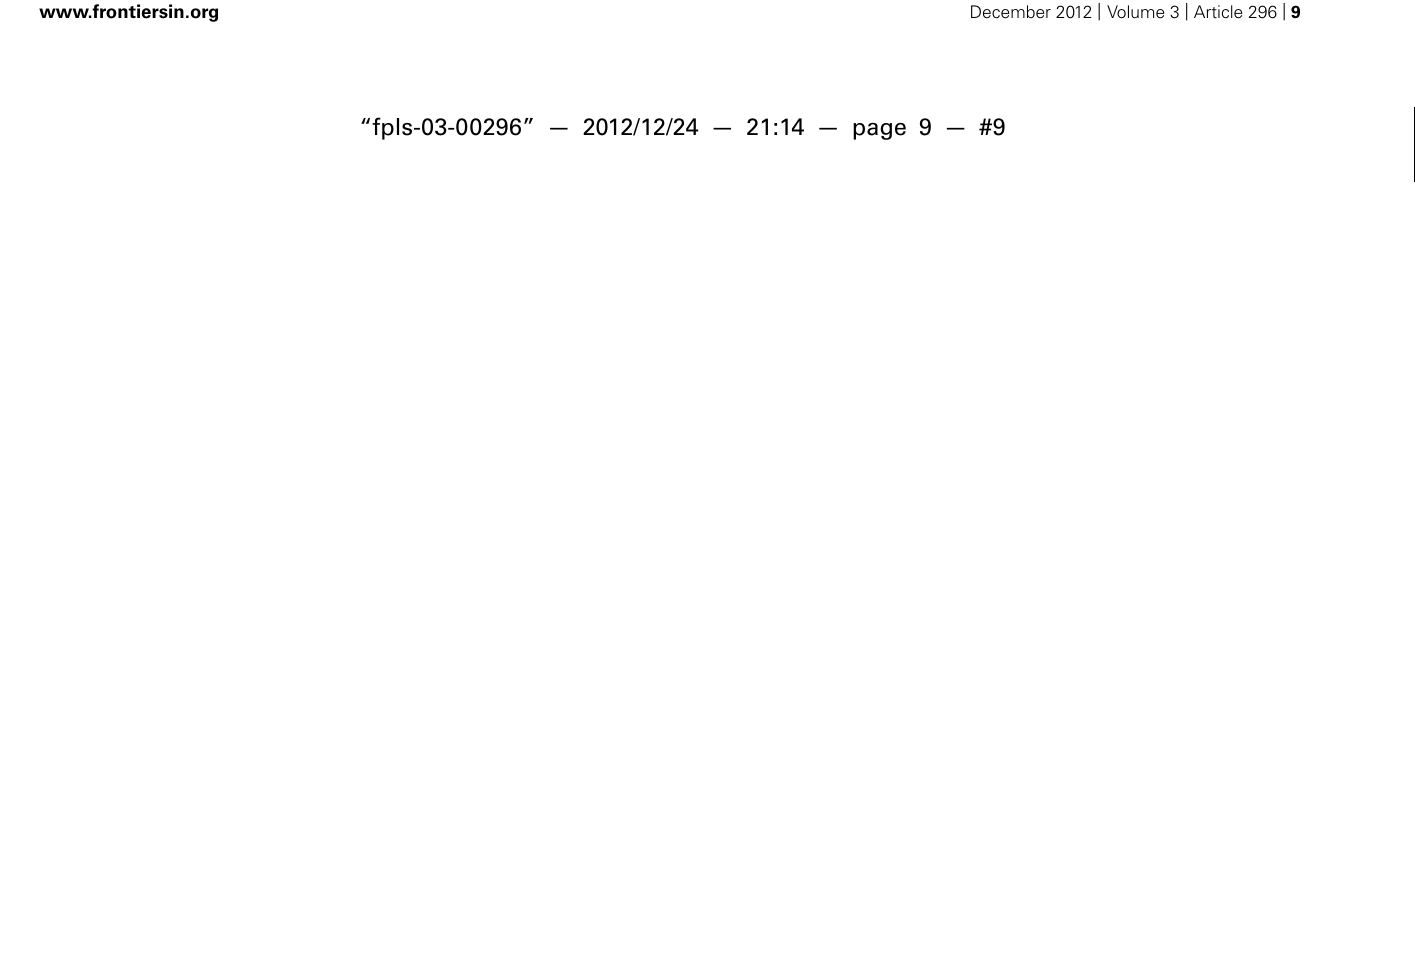
FIGURE 6 | Phylogenetic representation of the plant kingdom showing the major lineages and the observation of SL presence and the DAD2 and KAI2 genes in ancestral lineages (A). Photographs of Petunia, Norfolk pine, Black Ponga, and moss are authors own; Nitella image from http://www.nybg.org/science/conservation.php by Dr. Kenneth Karol; Chlamydomonas image from http://www.protisten.de/english/index.html by Wolfgang Bettighofer; Selaginella image from http://en.wikipedia.org/ wiki/File:Selaginella-sp.jpg by Luis Fernández García. A portion of a protein sequence alignment using Muscle (Edgar, 2004) of the Arabidopsis, rice,